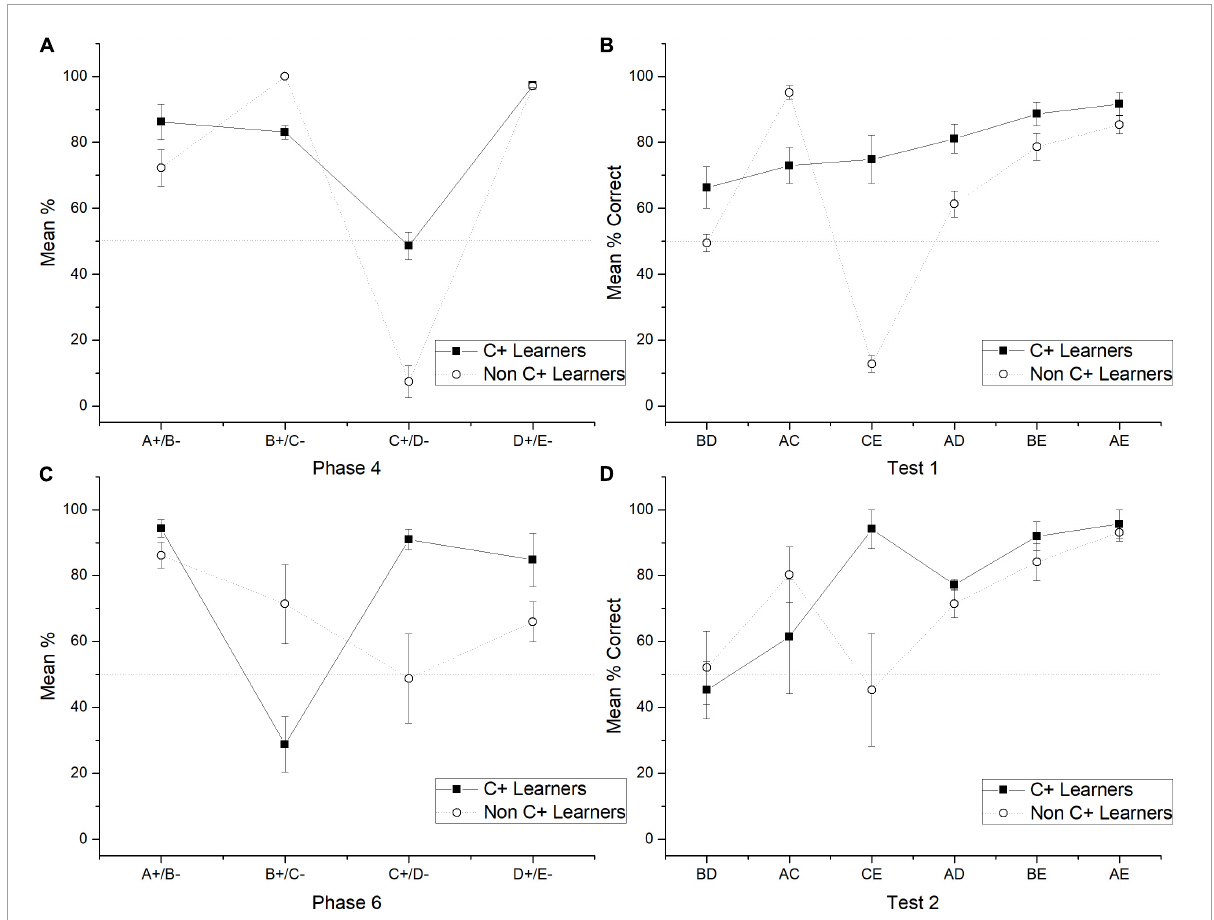
FIGURE3 Mean percentage (SEM ± ) of correct responses for C + learners and non C + learners in phase 4 (A) , test 1 (B) , phase 6 (C) and test 2 (D)